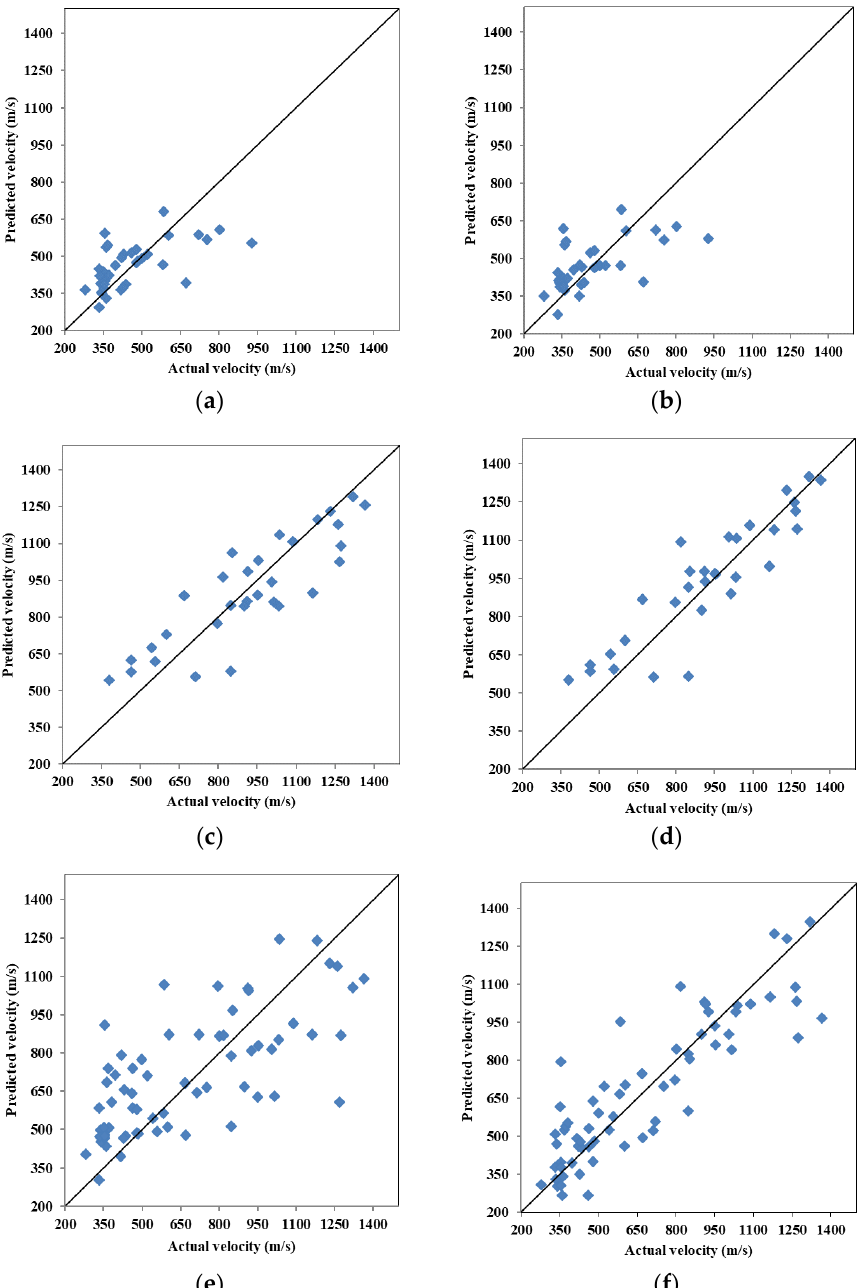
Figure 1. Graphical prediction accuracy of model for predicting seismic wave velocity, ( a ) field, with validation, ( b ) field, without validation, ( c ) lab, with validation, ( d ) lab, without validation, ( e ) field plus lab, with validation, ( f ) field plus lab, without validation.